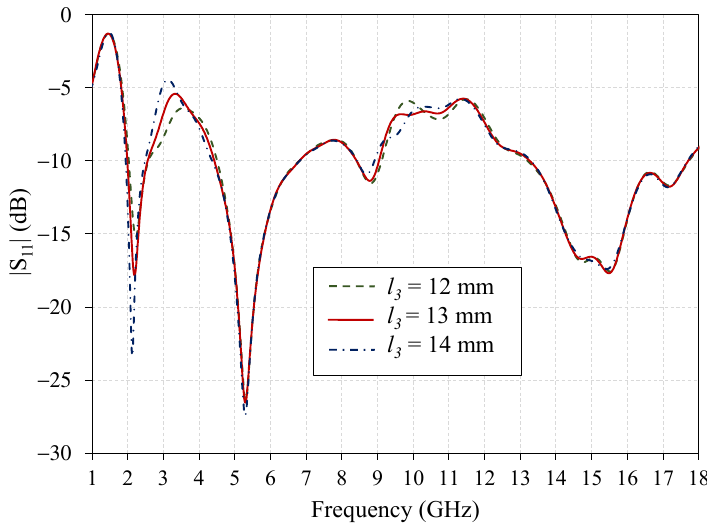
Figure 6. Simulated |S 11 | of the proposed antenna for various l 3 .